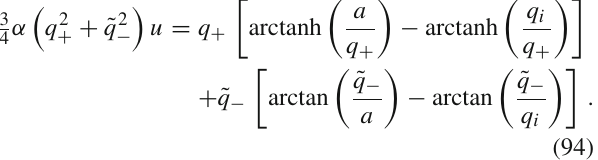
The location for the event horizon for the initial black hole and the final (cid:12) 0 . 6711 , r (cid:12) 2 . 9446, respectively. How- stable black hole are r h h 2 1 ever, the initial value of the apparent horizon (denoted by the orange point) is r AH ( 0 ) (cid:12) 2 . 5173 (cid:13) r h . This is a reminiscent of the fact 1 ˙ a ( 0 ) >